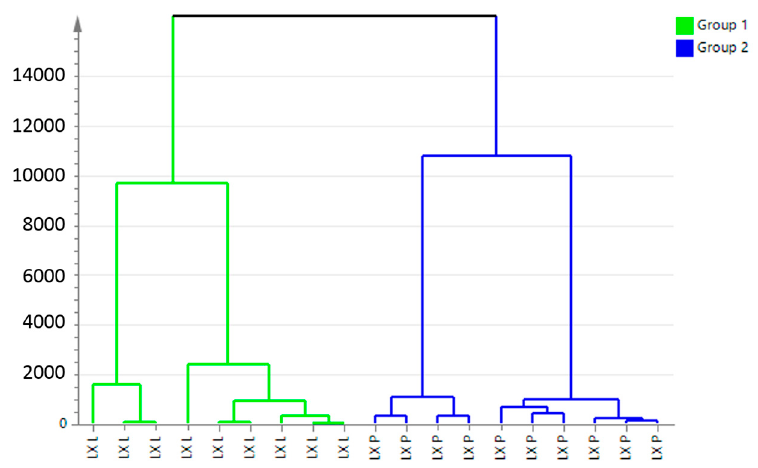
Figure 3. Hierarchical cluster analysis (HCA) dendrogram of LX-L and LX-P. LX-P: Natural air dried mountain cultivated ginseng; LX-L: Vacuum freeze-dried mountain cultivated ginseng.